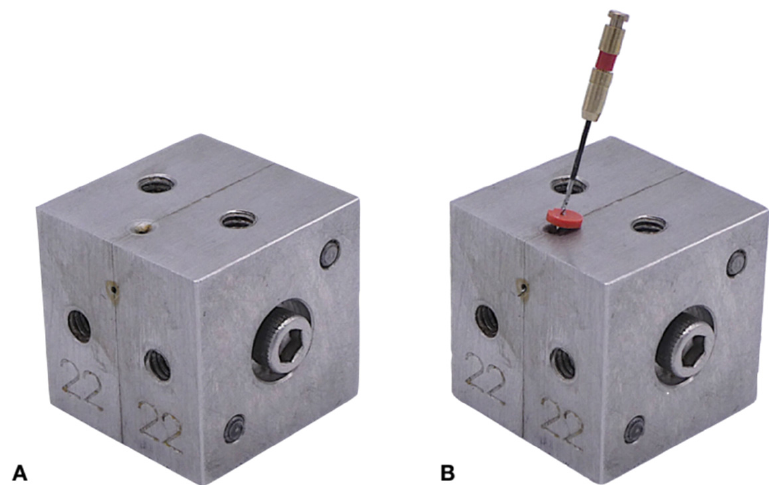
Figure 2. The custom-fabricated stainless steel cyclic fatigue testing device ( A ) with the tested endodontic instrument inserted into a simulated root canal ( B ).